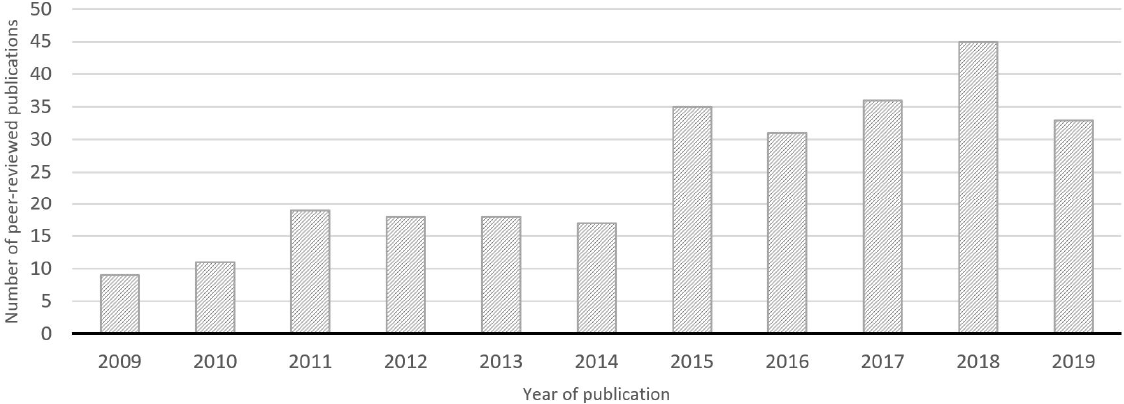
Figure 2. Number of peer-reviewed articles ( n = 272) focusing on the measurement of one or multiple socio-cultural benefits of food-producing urban green spaces per year of publication.